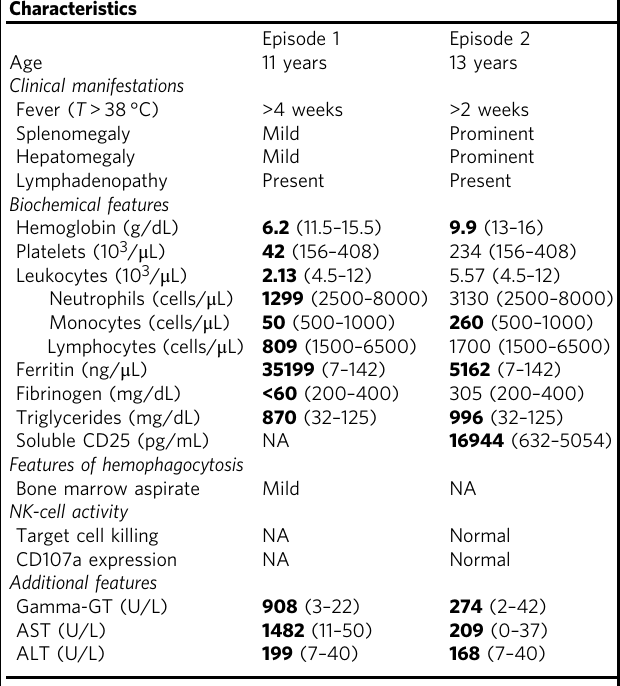
protocol 27 . After termination of Cyclosporin A (CSA), at age 13, disease reactivation was observed, and clinical course only